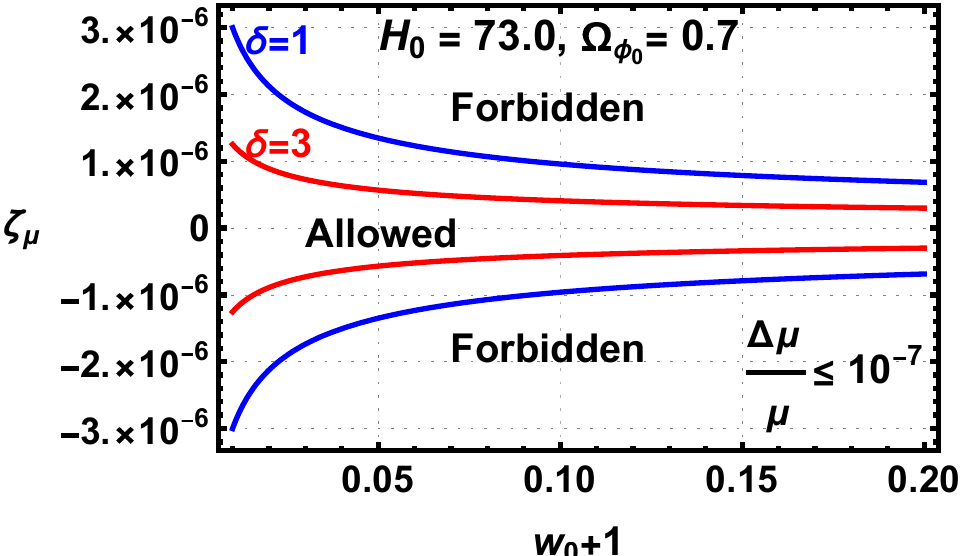
Figure 17. The forbidden and allowed regions in the w 0 − ζ µ plane determined by the constraints on the temporal deviation of the proton to electron mass ratio µ . Areas inside the two boundary lines for a case are allowed, while areas outside the two boundary lines are